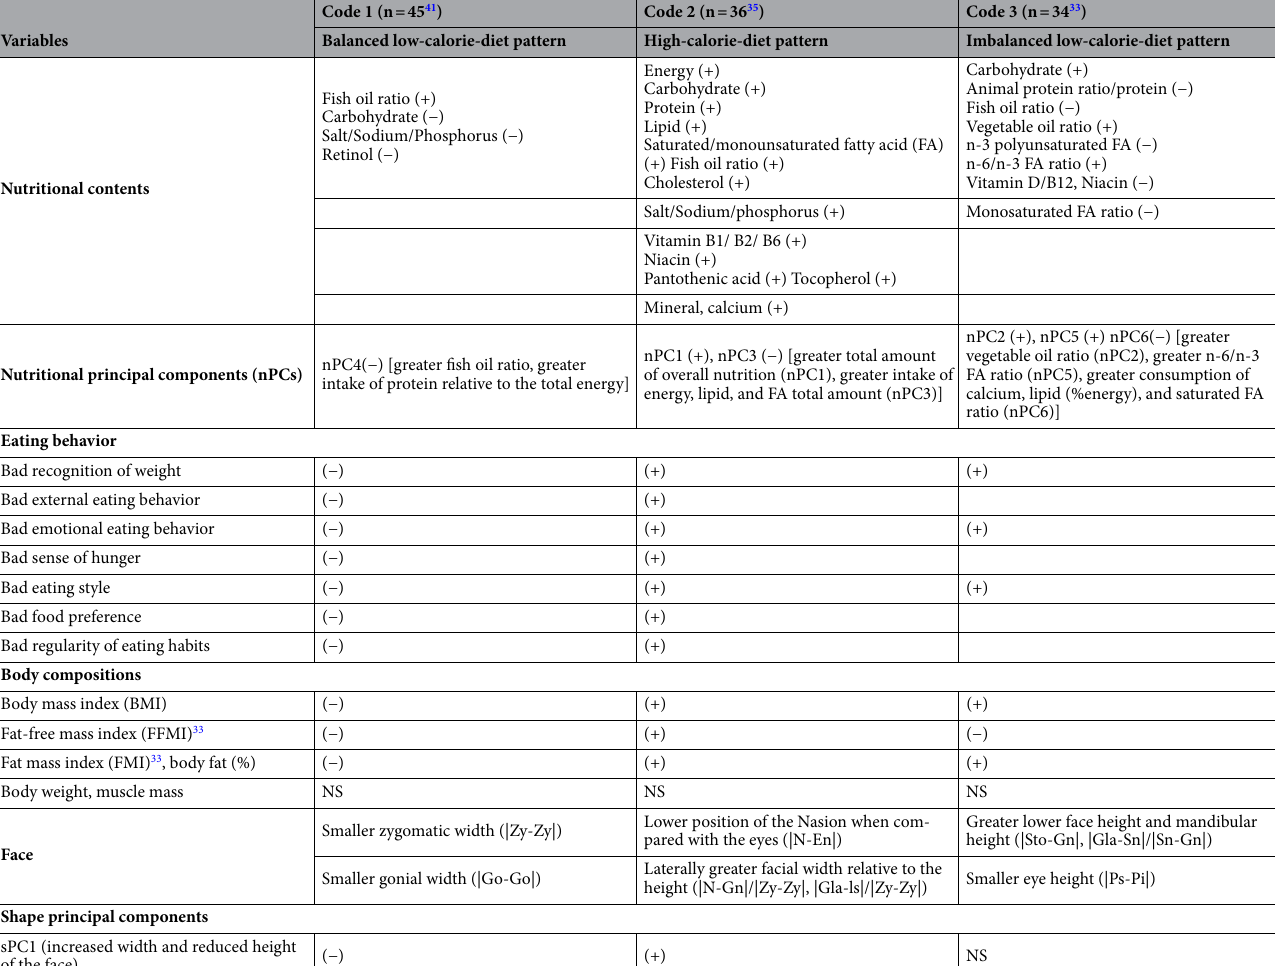
Table 1. Summary of the dietary intake and eating behavior and the corresponding physical condition, including facial characteristics. For details, please see Supplementary Tables S1–S3. (−) denotes a significantly smaller value than the other 2 groups; (+) denotes a significantly greater value than the other 2 groups; NS, not significant (ANOVA, p < 0.05, post-hoc test, Tukey–Kramer). [] indicates the number of faces